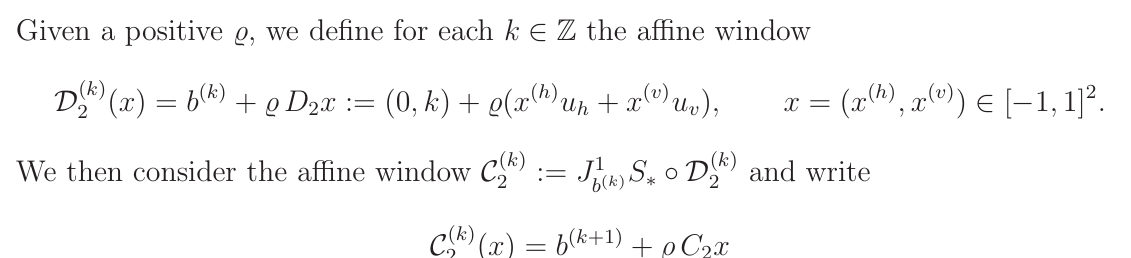
Fig. 4 Windows for the standard map S